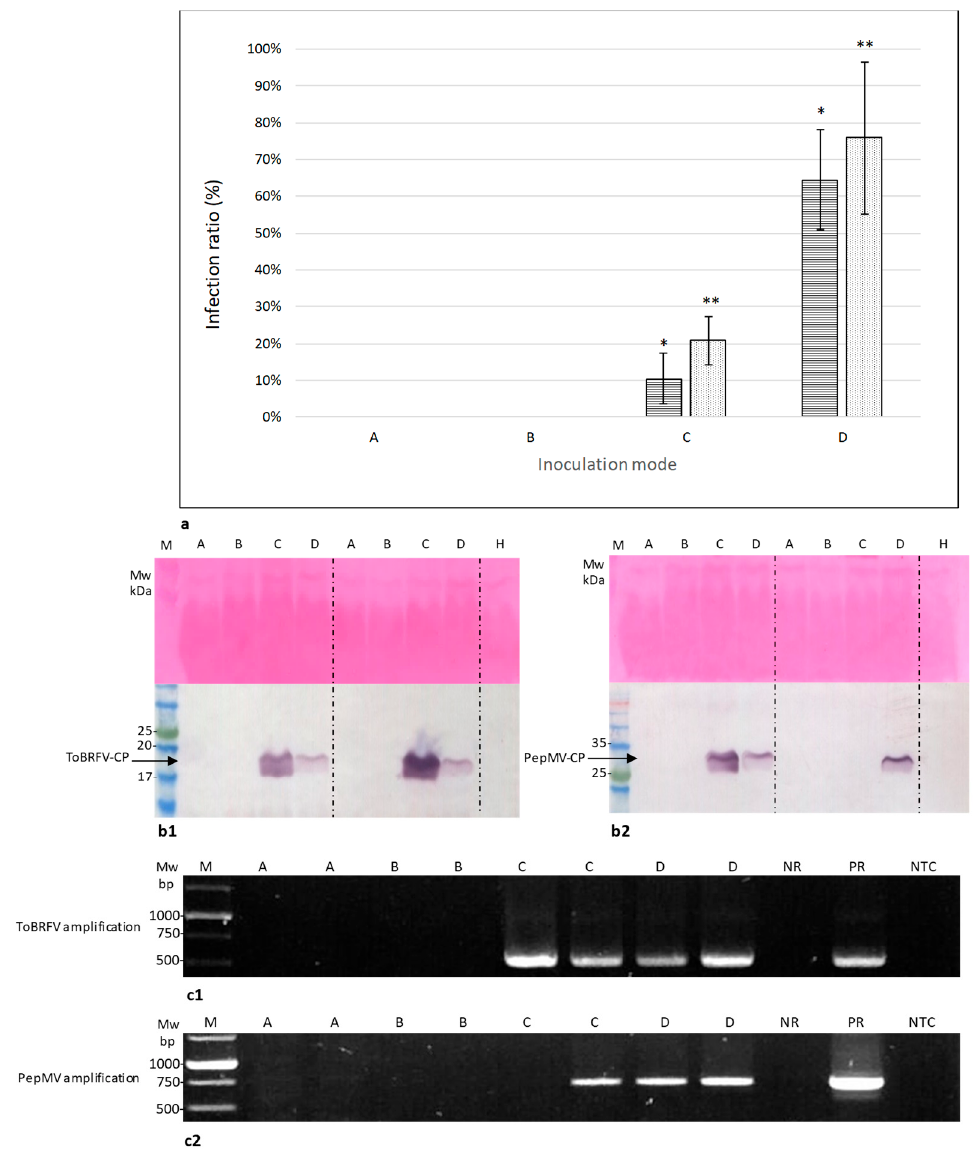
Figure 4. Pepino mosaic virus (PepMV) and tomato brown rugose fruit virus (ToBRFV) infectivity potential of the symptomatic tomatoes. ( a ) A graph of ToBRFV and PepMV infection ratio means ± standard deviations, using A–D inoculation modes, as calculated from exp. 1–4 (presented in Table 2); ( b ) Western blot analyses of tomato plants inoculated by two different fruits using A–D inoculation modes. ( c ) RT-PCR analyses of tomato plants inoculated by two different fruits using A–D inoculation